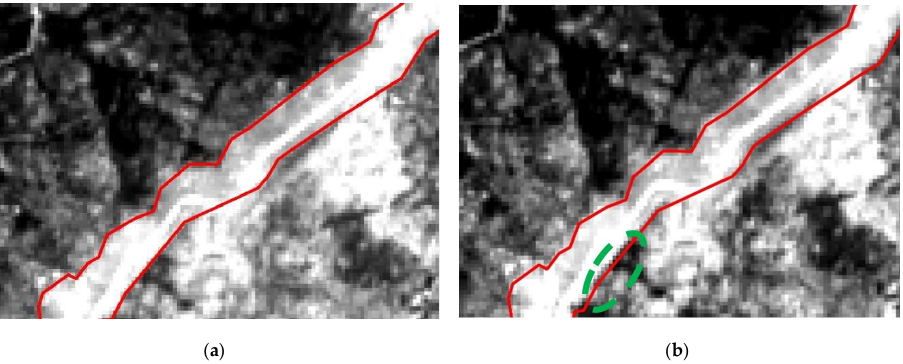
Figure 9. Geolocation correction in Band 04 images from Seia: ( a ) reference image (18-08-2017); ( b ) corrected image with an estimated offset of 0.7 North/South and -0.11 East/West (24-07-2017). To estimate the error of the geolocation method, two tests were made. The first (T1) applies to artificial geolocation errors, allowing an error estimation without uncertainty. The second (T2) tests a real scenario, where a set of images was compared with a reference and the uncertainty calculated. In T1 a set of images were randomly deviated between -1.5 and 1.5 pixels in both directions, creating an artificial geolocation error. The proposed algorithm for the geolocation error estimation compared the deviated observation with the corresponding non-deviated observation. The normalized root mean square error (NRMSE), presented in equation (1), between the calculated geolocation errors and the artificial geolocation errors generated was used as an evaluation metric of this algorithm. In equation (1) RMSE stands for root mean square error, (2), where 𝑦 (cid:3043) corresponds to the predicted values and 𝑇 the number of samples.